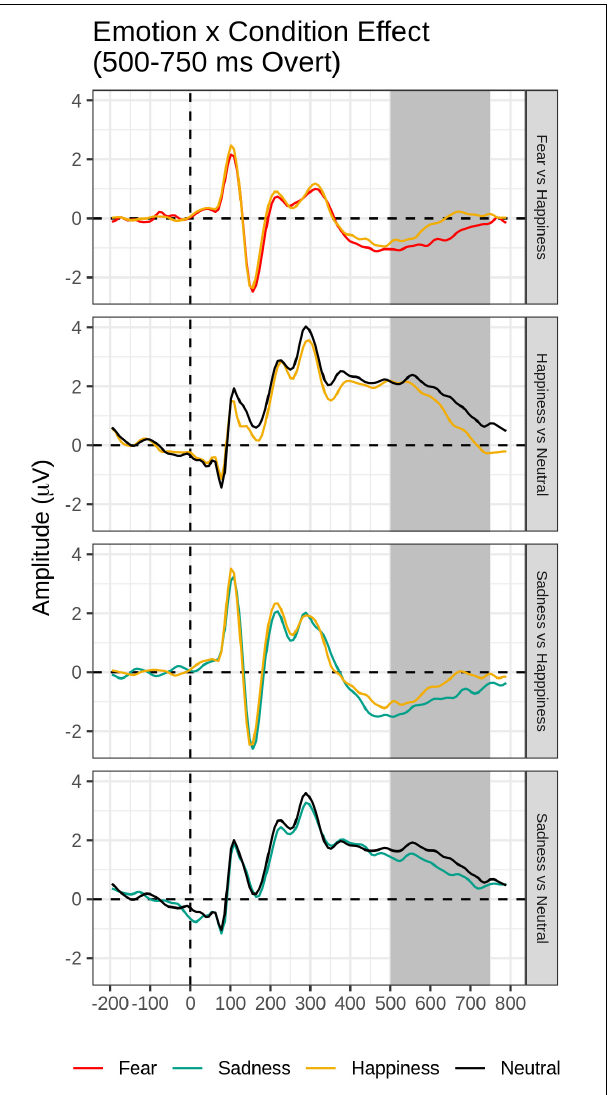
FIGURE 6 | Emotion × Task effect for the late time window (500–750 ms): In each panel, grand-average waveforms of the electrodes are included in the significant negative or positive clusters during the overt condition